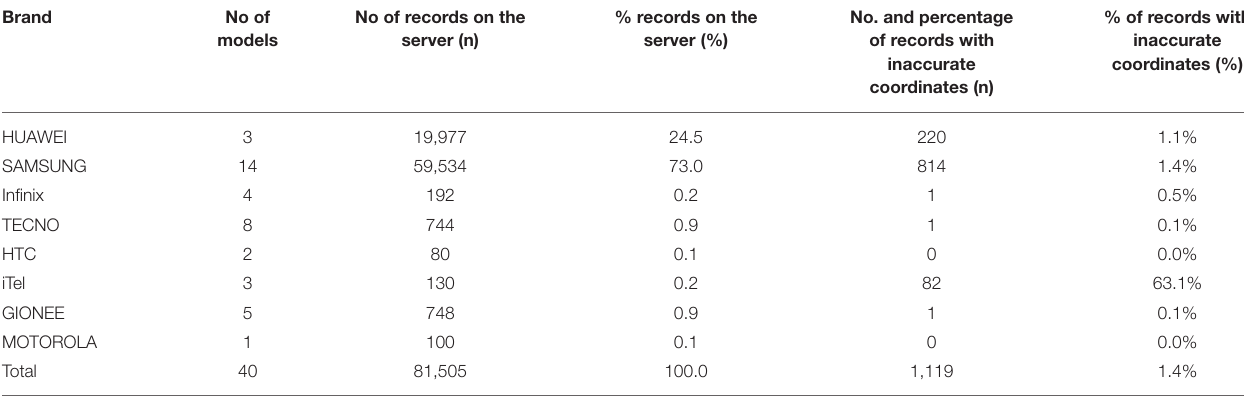
TABLE 2 | Number of records and those with inaccurate coordinates by mobile phone brand. Brand